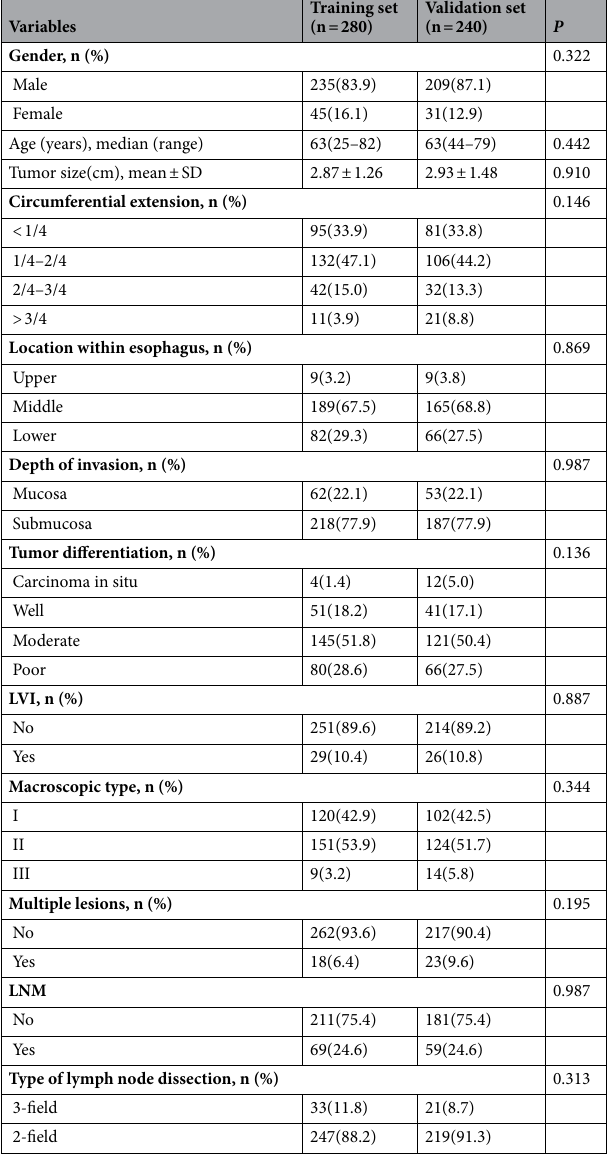
Table 1. Participant characteristics. LVI, lymphovascular invasion; LNM, Lymph node metastasis; I = superficial and protruding type; II = flat type; III = superficial and excavated type; P: Categorical variables— χ 2 test or Fisher’s exact test; Continuous variables—Mann–Whitney